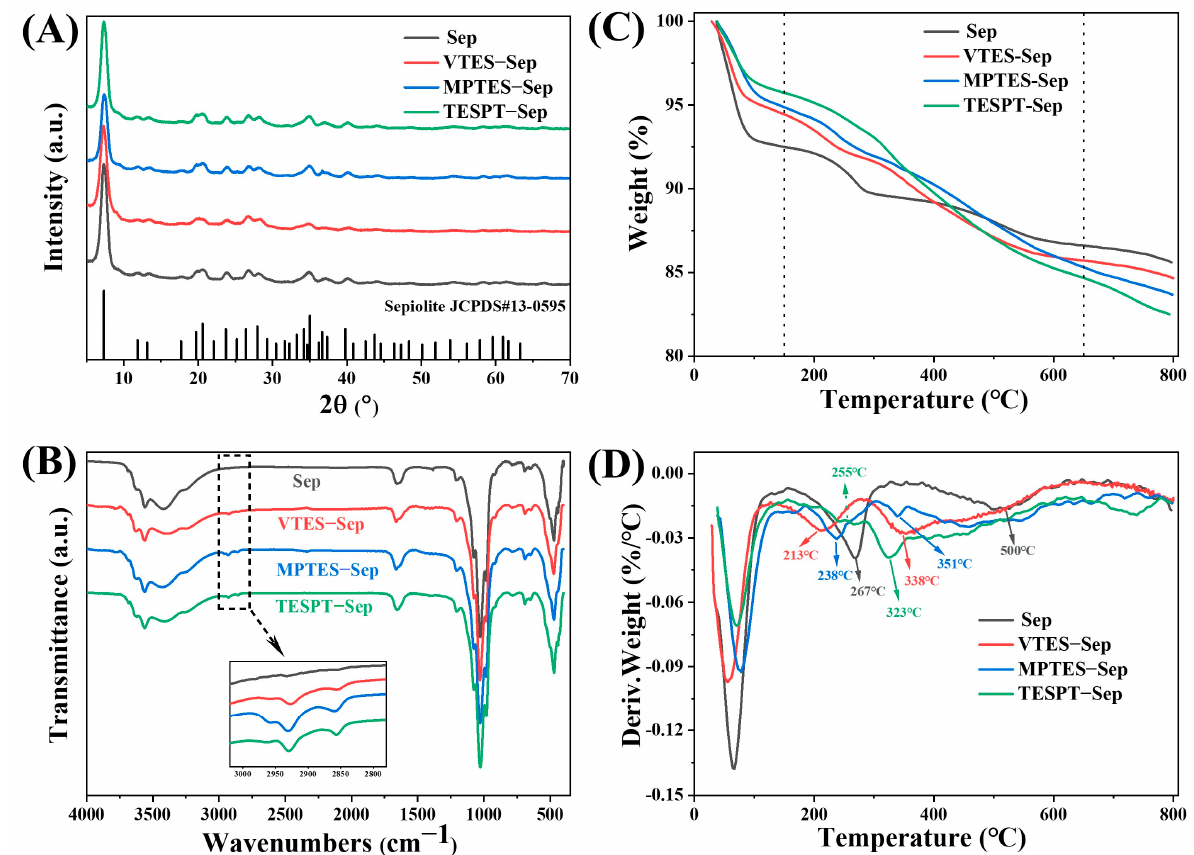
Figure 2. Characteristics of pure and modified sepiolite. ( A ) XRD patterns, ( B ) FTIR spectra, ( C ) TGA curves, and ( D ) derivative TGA curves.